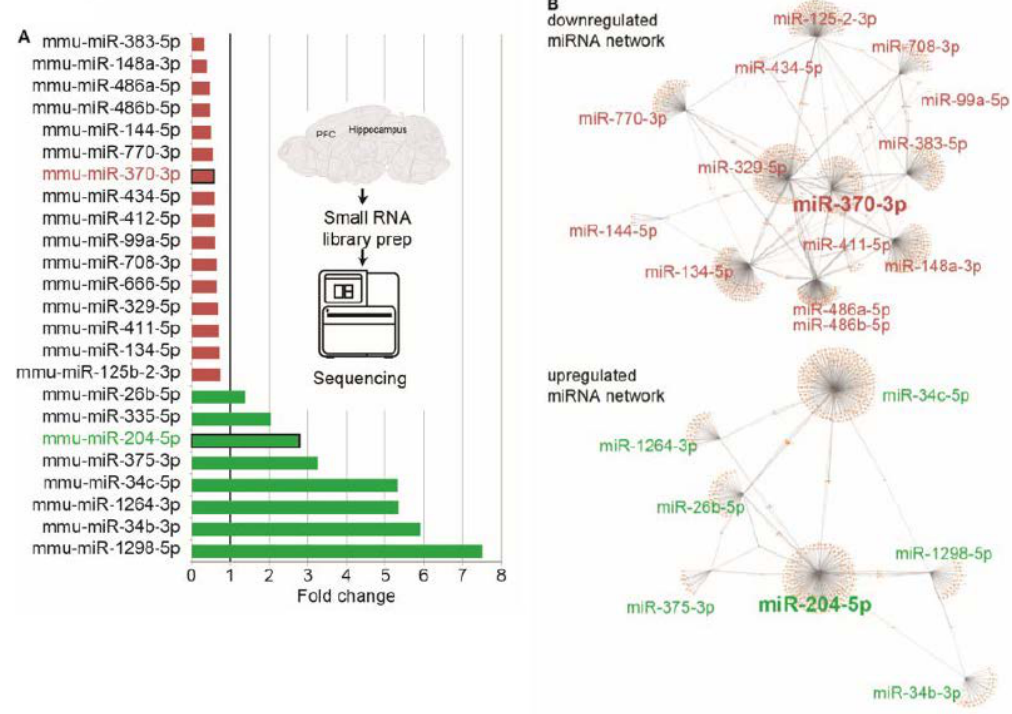
Figure 5. A . DE miRNAs in the TgR Hippocampus. Enriched DE miRNAs out of global miRNAs in the TgR hippocampus (minimal average expression of 300 normalized counts). Eight miRNAs targeting at least 5 cholinergic genes each and which are also known to be expressed in humans were DE in the TgR hippocampus, out of a total of 36 DE miRNAs. B . Network analysis for down- and up-regulated DE cholinergic-targeting miRNAs in the TgR hippocampus. Analysis was done using miRwalk 3.0 using maximum binding p -value of 1 and filter to 3’UTR binding and using miRDB database [73]. 3.6. The TgR PFC Shows More Variable Cholinergic Transcripts than the Caudate